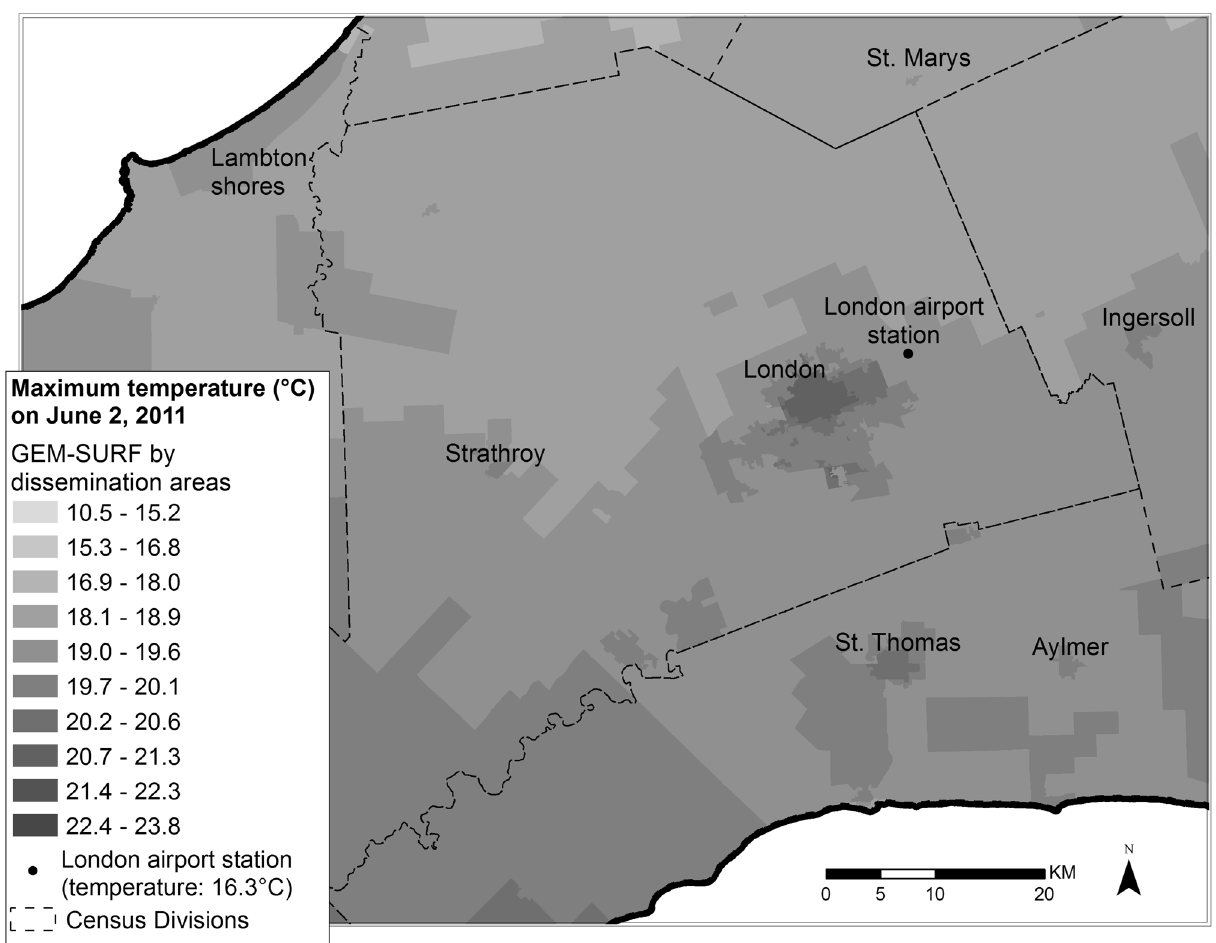
Figure 1. Comparison between maximum daily temperature ascertained by a single weather station on June 2nd 2011 (16.3 °C at London Ontario International Airport) and GEM-SURF temperatures across regional dissemination areas (10.5 to 23.8 °C). Map created by A.O. using ArcGIS software version 10.3 by ESRI, www. esri.